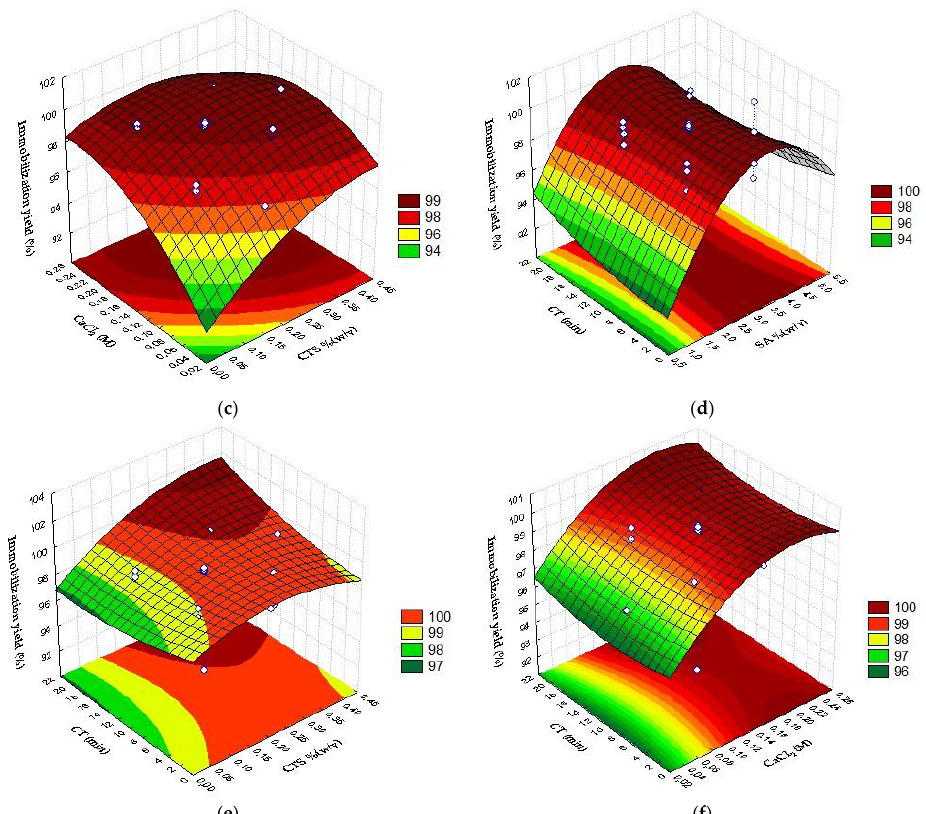
Figure 2. Response surface plots for the immobilization yield, IY (%), as a function of sodium alginate concentration (SA), chitosan concentration (CTS), calcium chloride concentration (CaCl 2 ) and complexation time (CT); ( a ) CTS × SA; ( b ) CaCl 2 × SA; ( c ) CaCl 2 × CTS; ( d ) CT × SA; ( e ) CT × CTS; ( f ) CT × CaCl 2 .